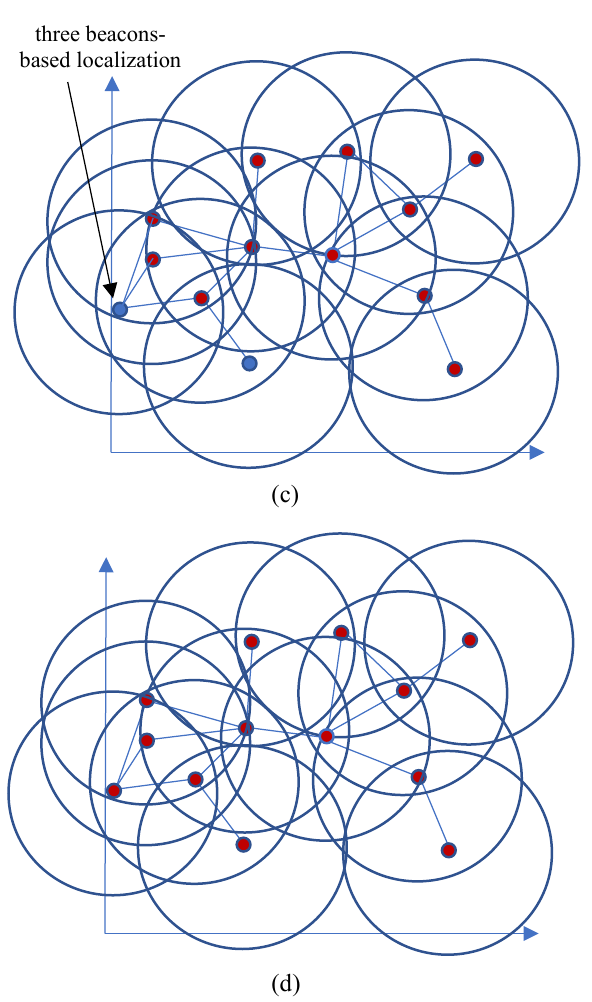
Figure 4. (a) Initial one beacon-based localization, (b) One and two beacon-based localization, (c) One and three beacon-based localization, (d) Localized sensor network Figure 5. Number of localized nodes vs position